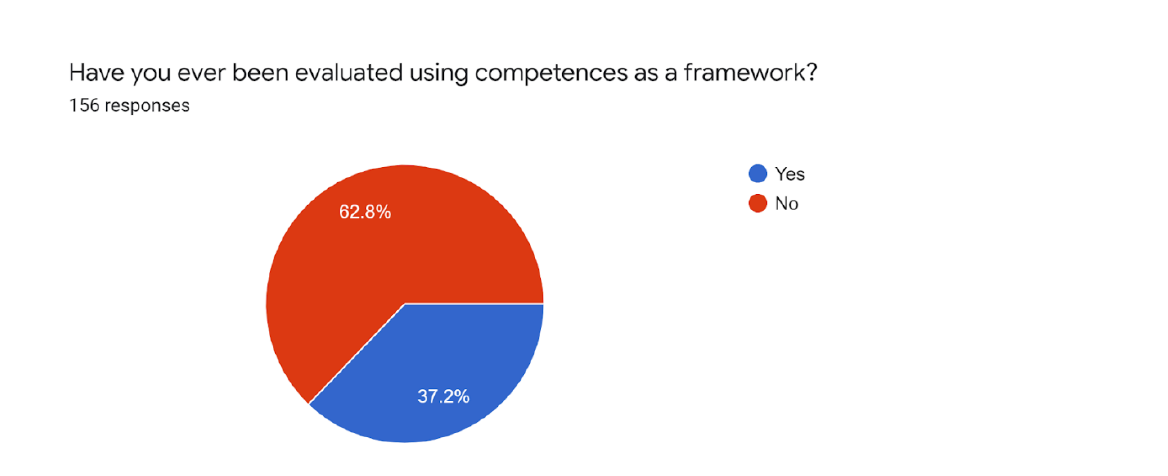
CHART 1. USE OF COMPETENCIES AS A